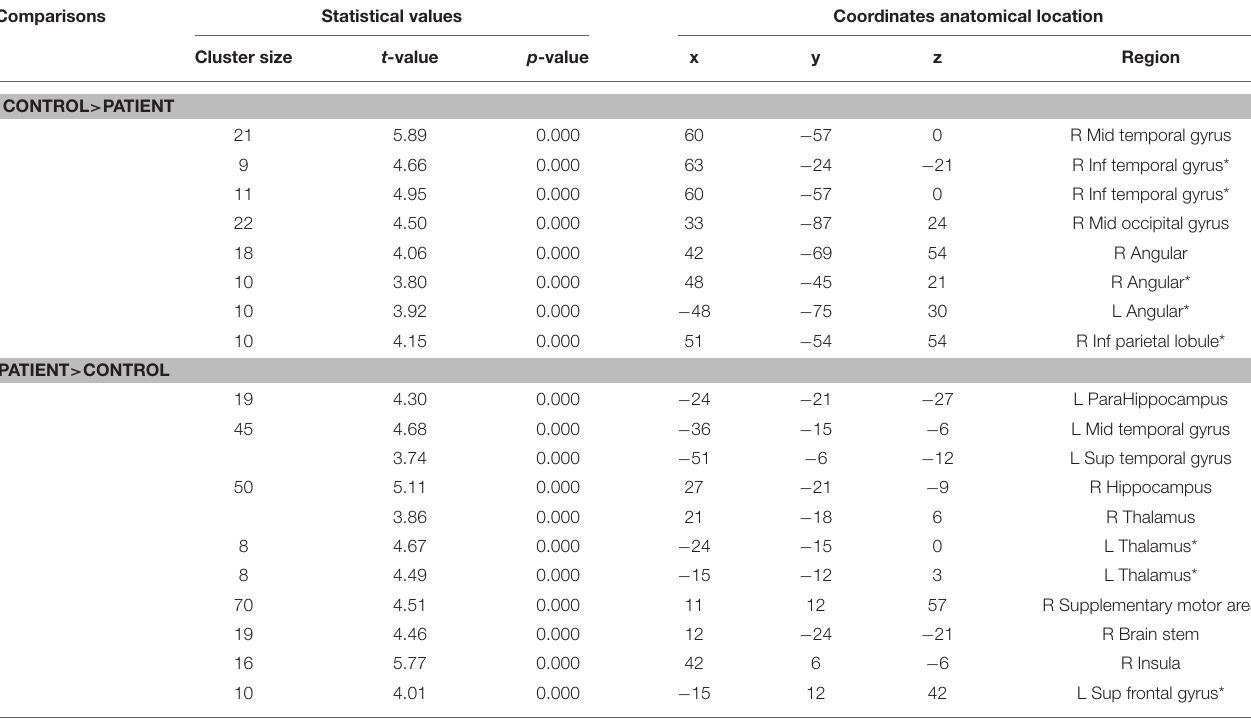
TABLE 3 | Summary of significant activations between patient and control from the whole-brain analysis.